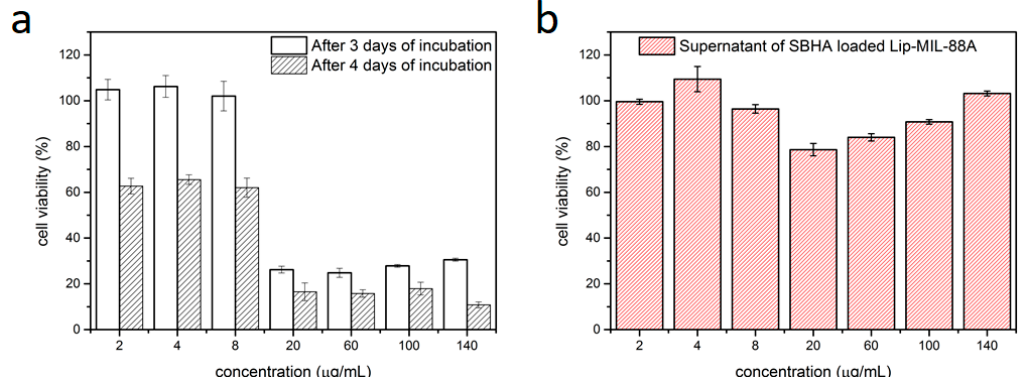
Figure 3. Liposome-coated MIL-88A nanoparticles loaded with calcein after two ( a ) and three ( b ) days of incubation with HeLa cells. The cells have been marked with CellMask Orange. The scale bars correspond to 30 µm ( a ) and 20 µm ( b ).